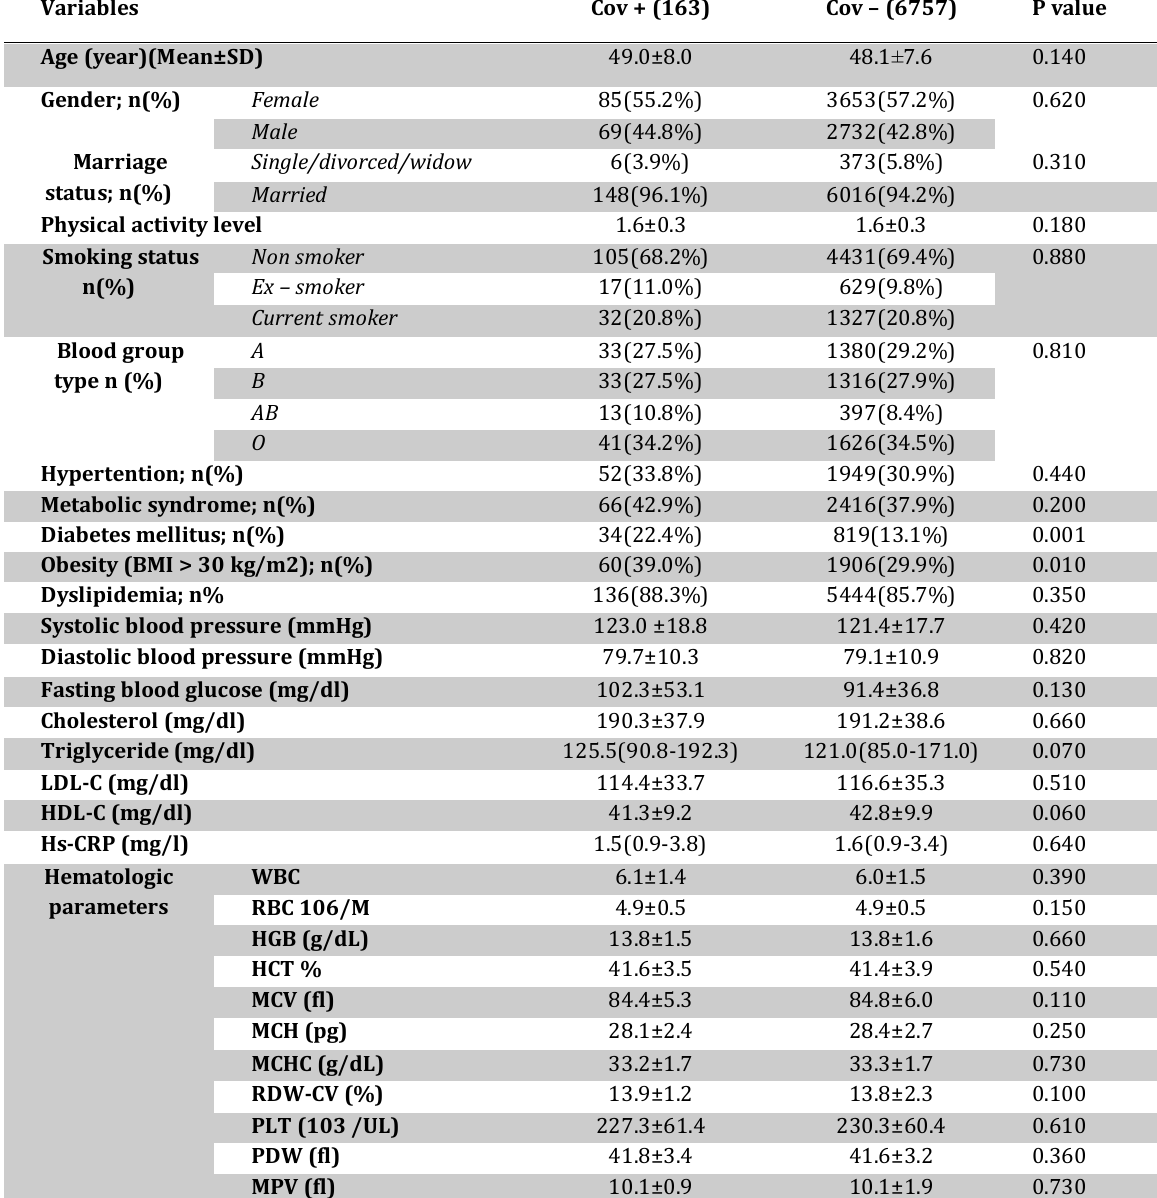
Table 1: Summary demographics for subjects with COVID-19 in MASHAD study